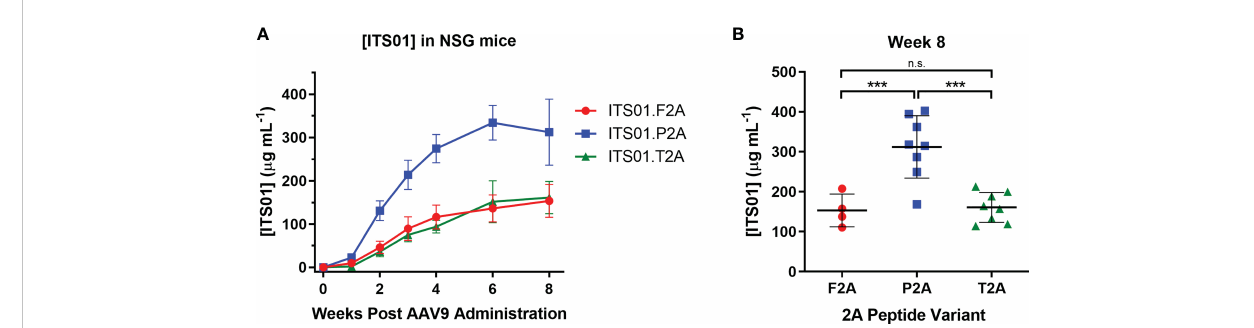
FIGURE 2 ITS01 expression from AAV9 vectors using different 2A peptides in NSG mice. (A) Three groups of four (F2A) or eight (P2A and T2A) NSG mice each were administered a fi xed dose of 5×10 10 vector genomes (vg) AAV9 vectors (about 2.5×10 12 vg/kg) encoding ITS01 using the indicated 2A peptide (F2A – red, P2A – blue, T2A – green) in a 25 µL volume in the left gastrocnemius muscle. Blood draws were performed over eight weeks and plasma samples were analyzed by gp120 ELISA to determine ITS01 concentrations. (B) Comparison of ITS01 concentrations at week 8 post AAV administration. Each dot represents an individual animal. Mean is represented by the black bar. Error bars indicate S.D. Statistical comparison of the 2A peptide groups was determined by a one-way ANOVA with Tukey ’ s multiple comparison test. Statistical signi fi cance is de fi ned as *** indicates P value ≤ 0.001; n.s., indicates not signi fi cant.